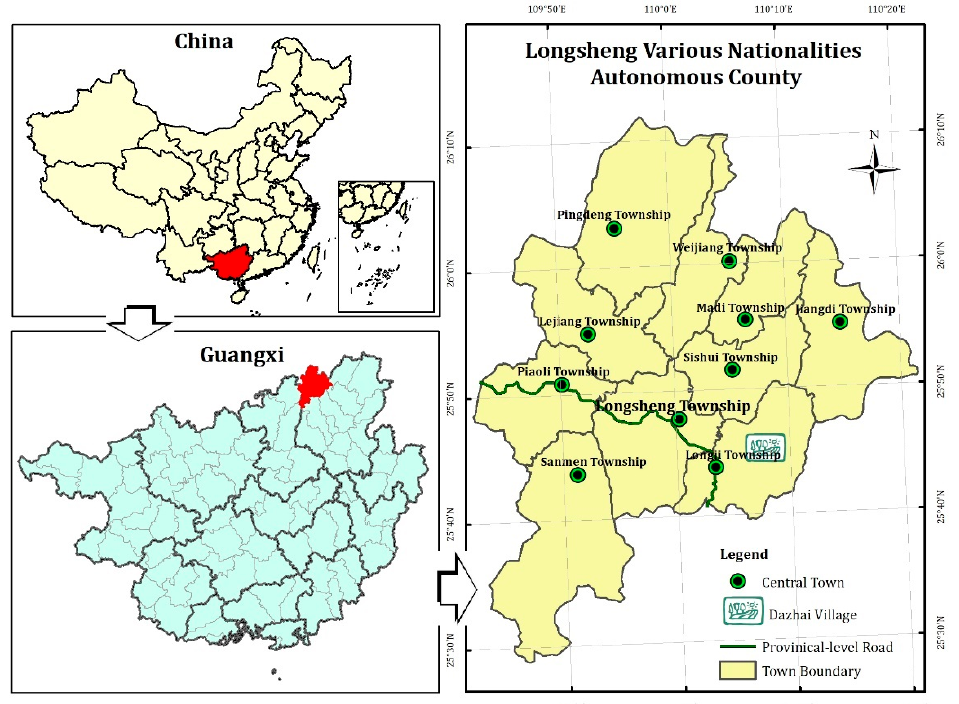
Figure 1. Location of Dazhai terraces.